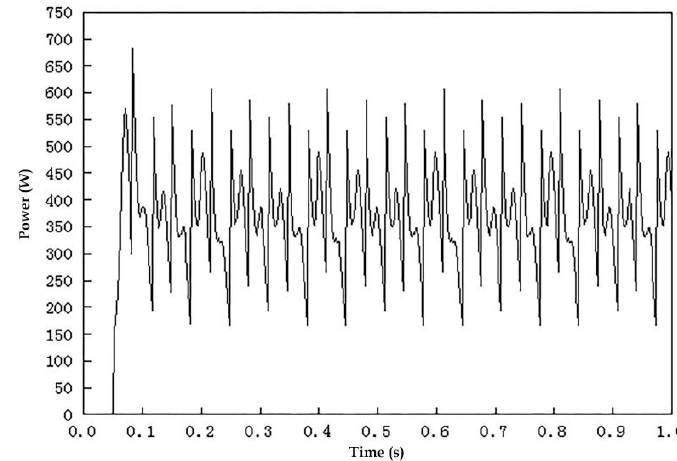
Figure 16. Three-phase Generation Power Waveform of DLSRG.